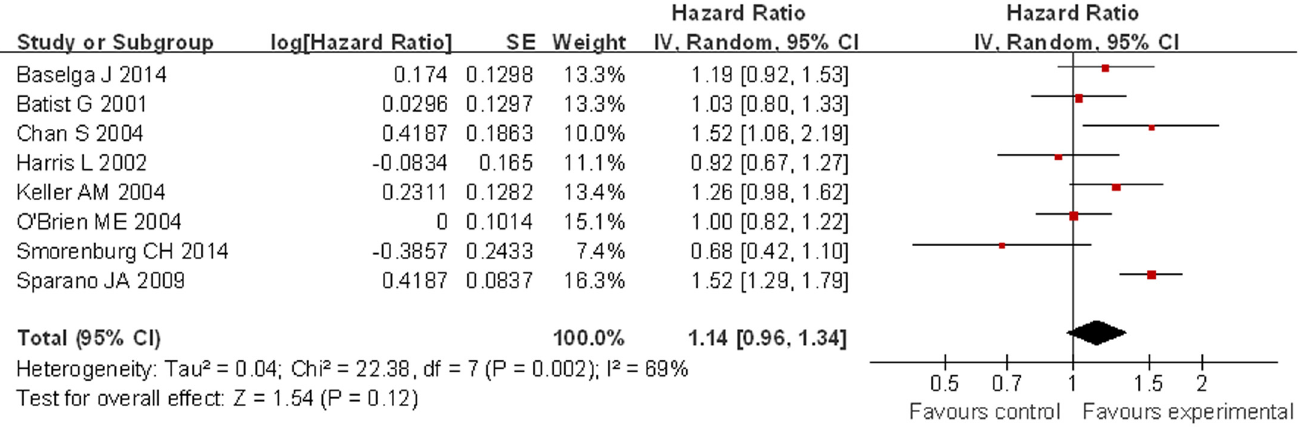
Fig 3. Forest plot of PFS comparison between two